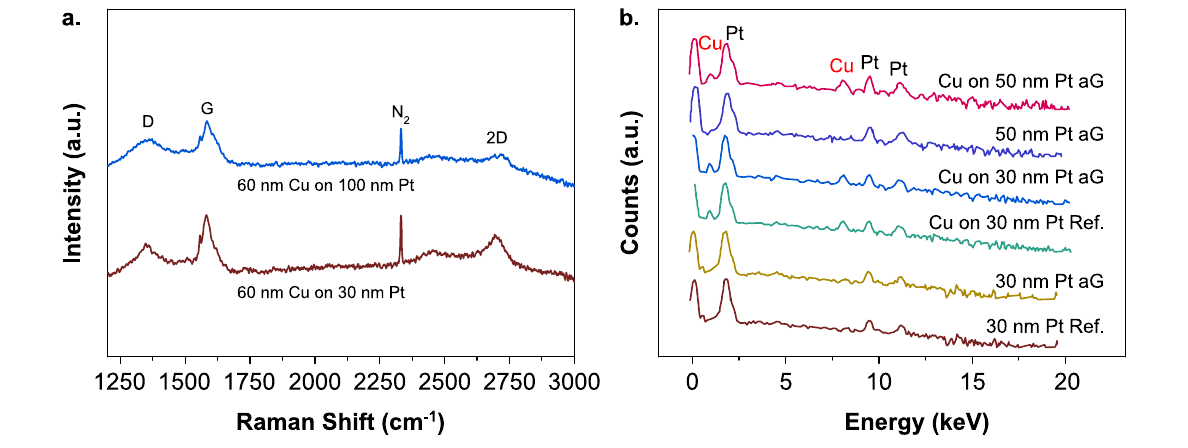
Fig. 4 Characterisation of Pt–Cu heterostructures for CVD growth of graphene. a Raman spectra of graphene grown at 800 °C on 30 + 60 nm Pt–Cu (red) and 100 + 60 nm Pt–Cu (blue)